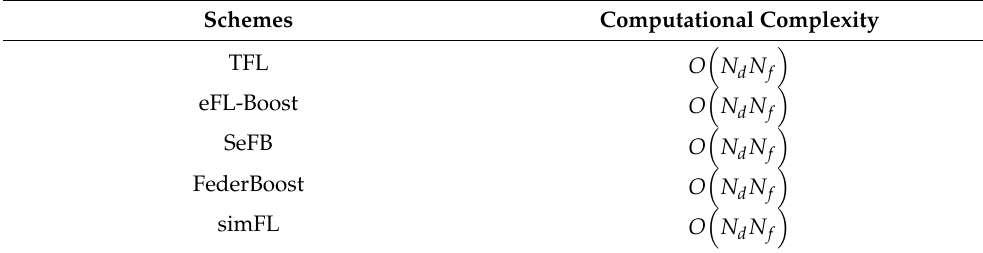
Table 3. Computational complexity required by each scheme for each